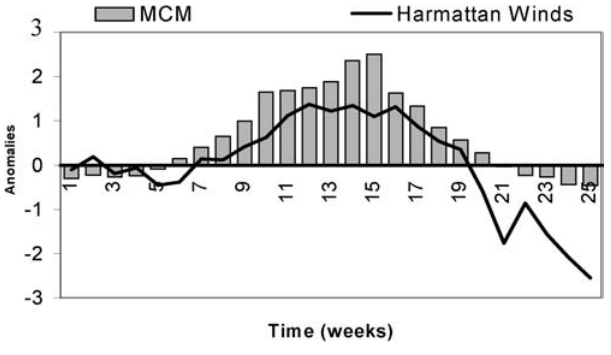
Figure 3. Temporal Patterns of Epidemics and Climate Weekly means of the Harmattan wind index over the 1994–2002 period and mean seasonal pattern of the number of cases of MCM (in standardized anomalies). DOI: 10.1371/journal.pmed.0020006.g003